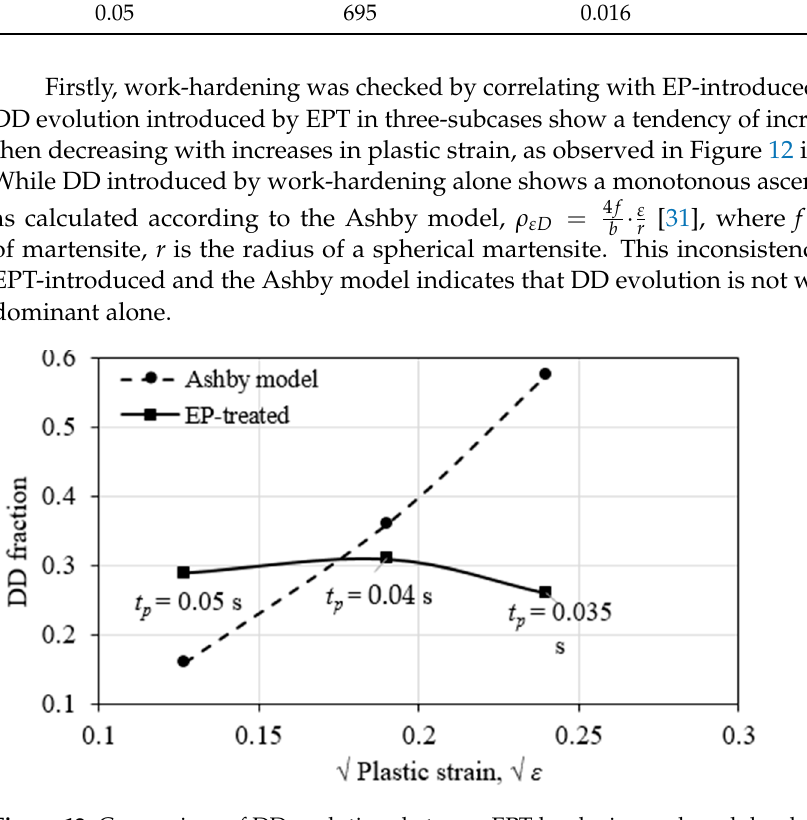
Figure 12. Comparison of DD evolutions between EPT-hardening and work-hardening.